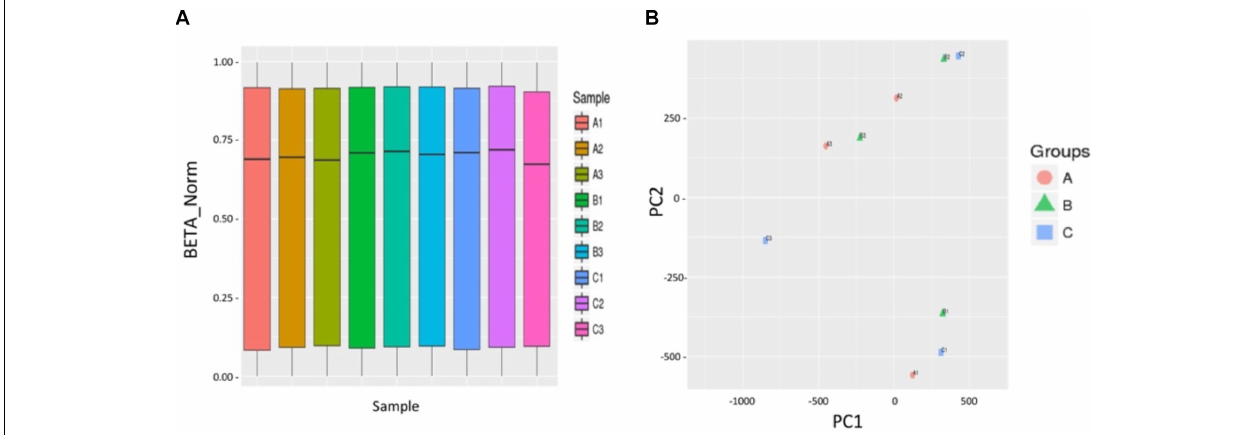
FIGURE 3 | The culture and activation process of ovarian tissue in vitro did not cause abnormal DNA methylation. (A) No significant differences in total genome DNA methylation between three groups of human ovarian tissues were observed: normal group A (A1, A2, A3) (normal human ovarian fragment), control group B (B1, B2, B3) (treated with culture media only), and activated group C (C1, C2, C3) (treated with 10 µ M activator MHY1485). The abscissa indicates the nine sample names, and the ordinate represents the methylation level (standardized beta value). (B) The PCA chart indicates the similarity between the samples by the method of decreasing dimensions. The three groups did not cluster together, indicating that the similarity of the samples within the same group was poor, and there were no significant differences between the three groups. | Delta Beta| ≥ 0.12 ( P < 0.01) is used to screen out the different sites, Delta Beta ≥ 0.12 indicates that the degree of methylation is increased, and Delta Beta ≤ –0.12 indicates that the degree of methylation is decreased. Three volcano plots between groups show the differential of the methylation